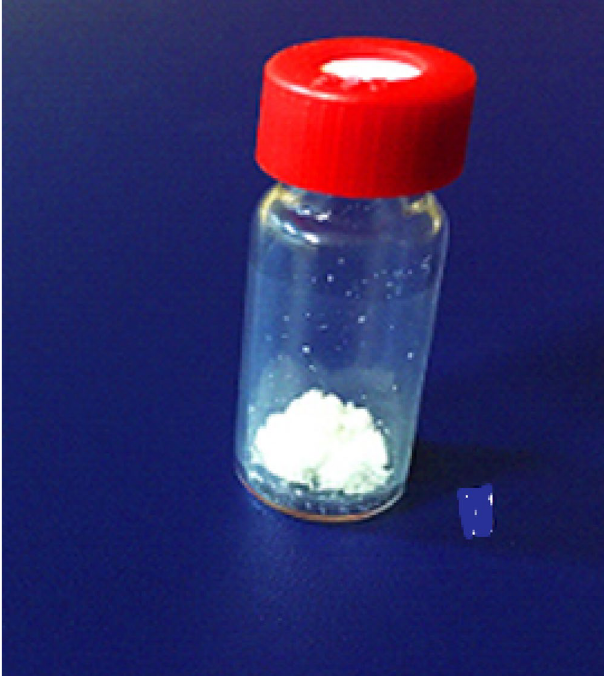
Figure 8. cPNIPAAM produced in emulsion of SC-CO 2 in water after